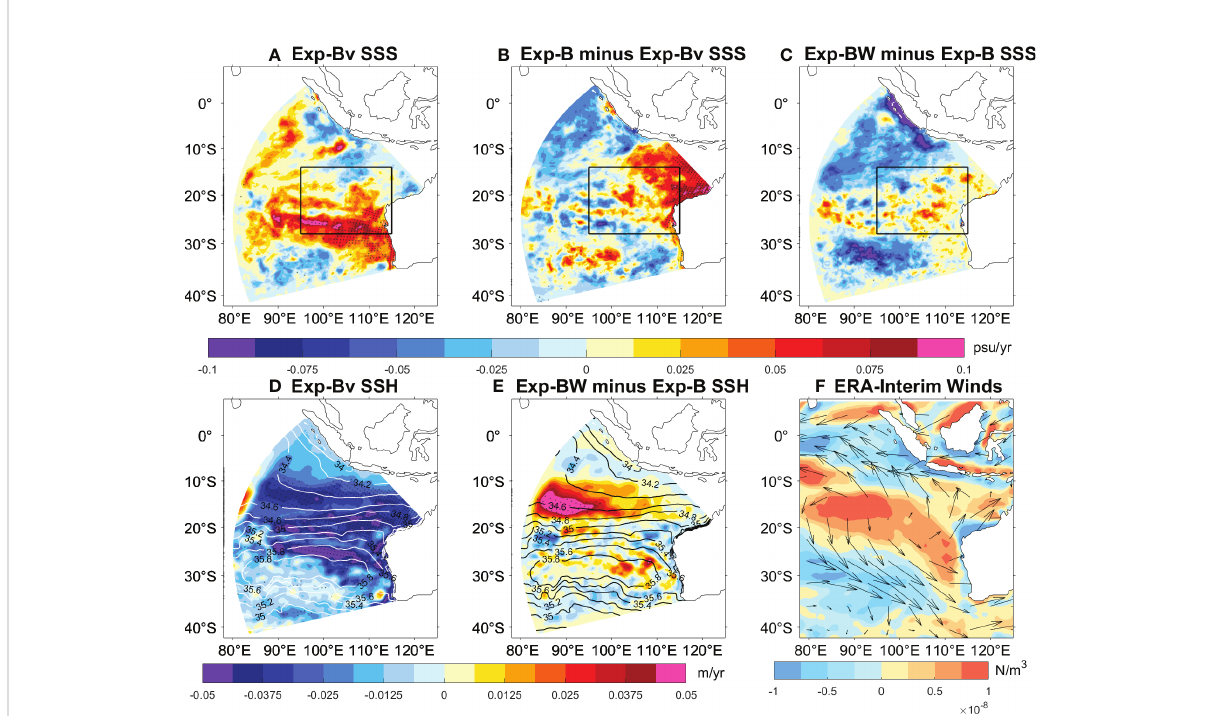
FIGURE 14 (A) Linear trends maps of SSS derived from Exp-Bv for the composite of 2000-2005 and 2011-2016 minus that of 1995-2000 and 2005-2011. (B, C) As in (A) , but for Exp-B minus Exp-Bv and Exp-BW minus Exp-B, respectively. (D) Linear trends maps of SSH derived from Exp-B for the composite of 2000-2005 and 2011-2016 minus that of 1995-2000 and 2005-2011. (E) As in (D) , but for Exp-BW minus Exp-B. (D, E) The contour lines represent the climatic salinity of the Ctr data from 1995 to 2016. (F) Linear trends maps of wind stress curl anomaly (shaded) and wind anomaly (vector) derived from ERA-Interim for the composite of 2000-2005 and 2011-2016 minus that of 1995-2000 and 2005-2011. Stippling indicates signi fi cant at 90% con fi dence level based on a Mann-Kendall test. Black lines denote the SEIO.